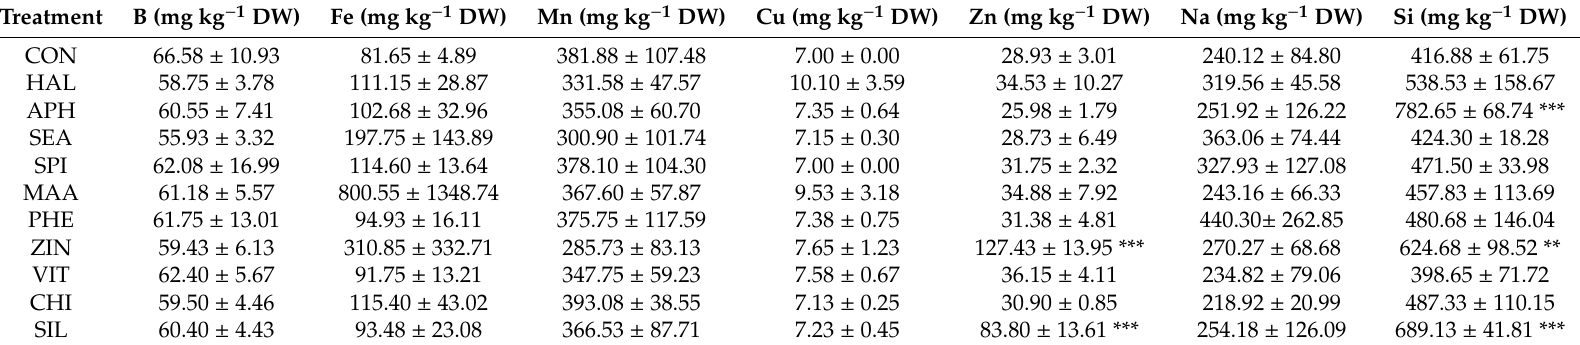
Table 6. Micronutrient concentrations in strawberry leaves at 90 DAT (days after transplanting) as a ff ected by biostimulant applications.